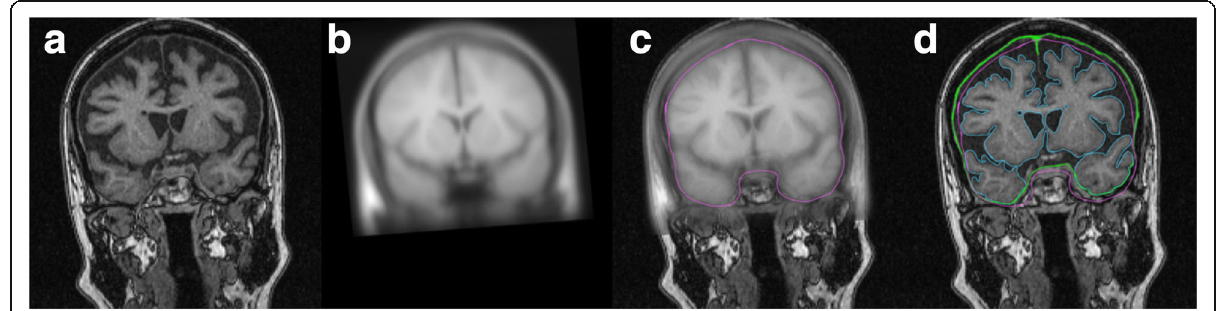
Fig. 1 Illustration of FreeSurfer atlas alignment for estimation of intracranial volume. a T1-weighted image of a participant with frontal lobe dementia. b MNI305 atlas aligned to the T1-weighted image. c T1-weighted image with the aligned atlas overlaid and the intracranial surface of the atlas delineated (pink). d T1-weighted image with the brain surface (blue contour), the intracranial surface of the atlas (pink), and the actual intracranial surface (green) delineated; the atlas surface (pink) seems to follow an outer perimeter set by the gyri rather than following the intracranial surface